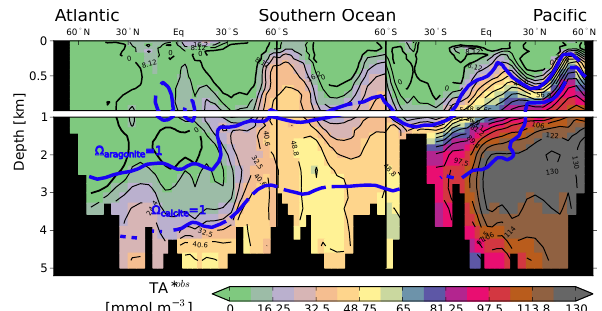
Figure 1. The TA ∗ tracer captures exclusively the influence of CaCO 3 dissolution on alkalinity. An observationally based esti- mate of the TA ∗ distribution (mmolm − 3 ) yielding an inventory of ∼ 37 . 5PmolC of which ∼ 41% comes to lie above the calcite satu- ration horizon. The calcite ( σ calcite =1) and aragonite ( σ aragonite =1) saturation horizon are shown by the blue lines. Displayed are results for a cross section through the Atlantic (25 ◦ W), across the Southern Ocean (58 ◦ S) into the Pacific, and through the Pacific (175 ◦